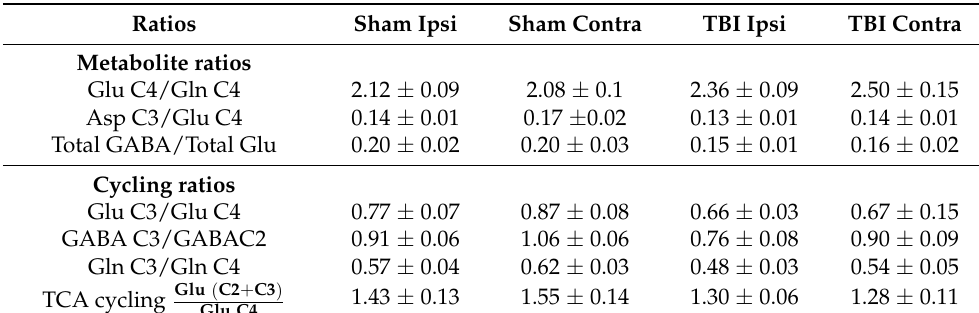
Table 2. Ratios of metabolite labeling and cycling. Ratios